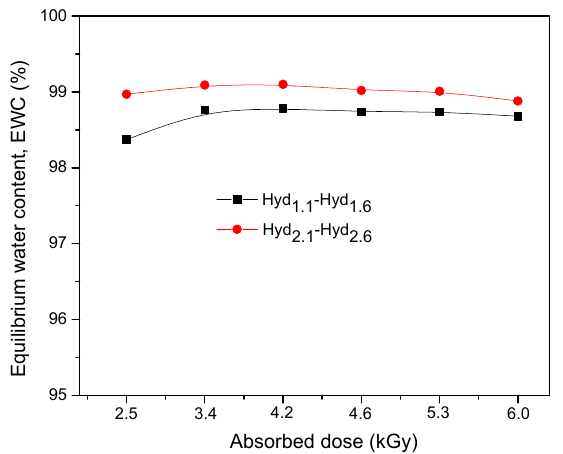
Figure 4. The effect of the absorbed dose and amount of TMPT on the equilibrium water content of hydrogels.